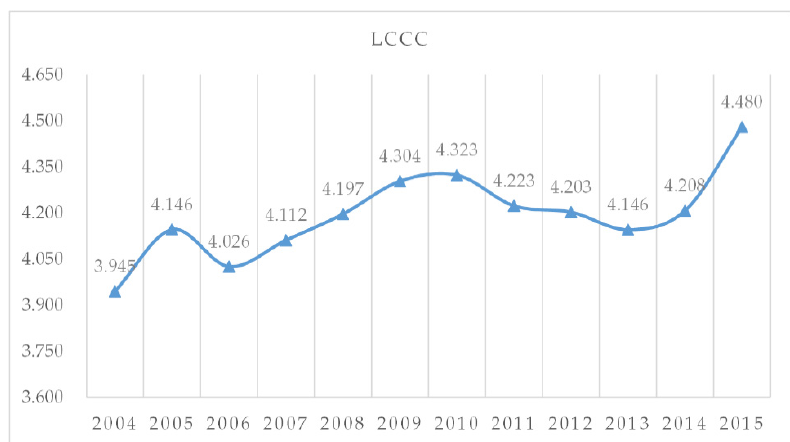
Figure 3. The overall tendency of the LCCC in the HCUA during 2004–2015.